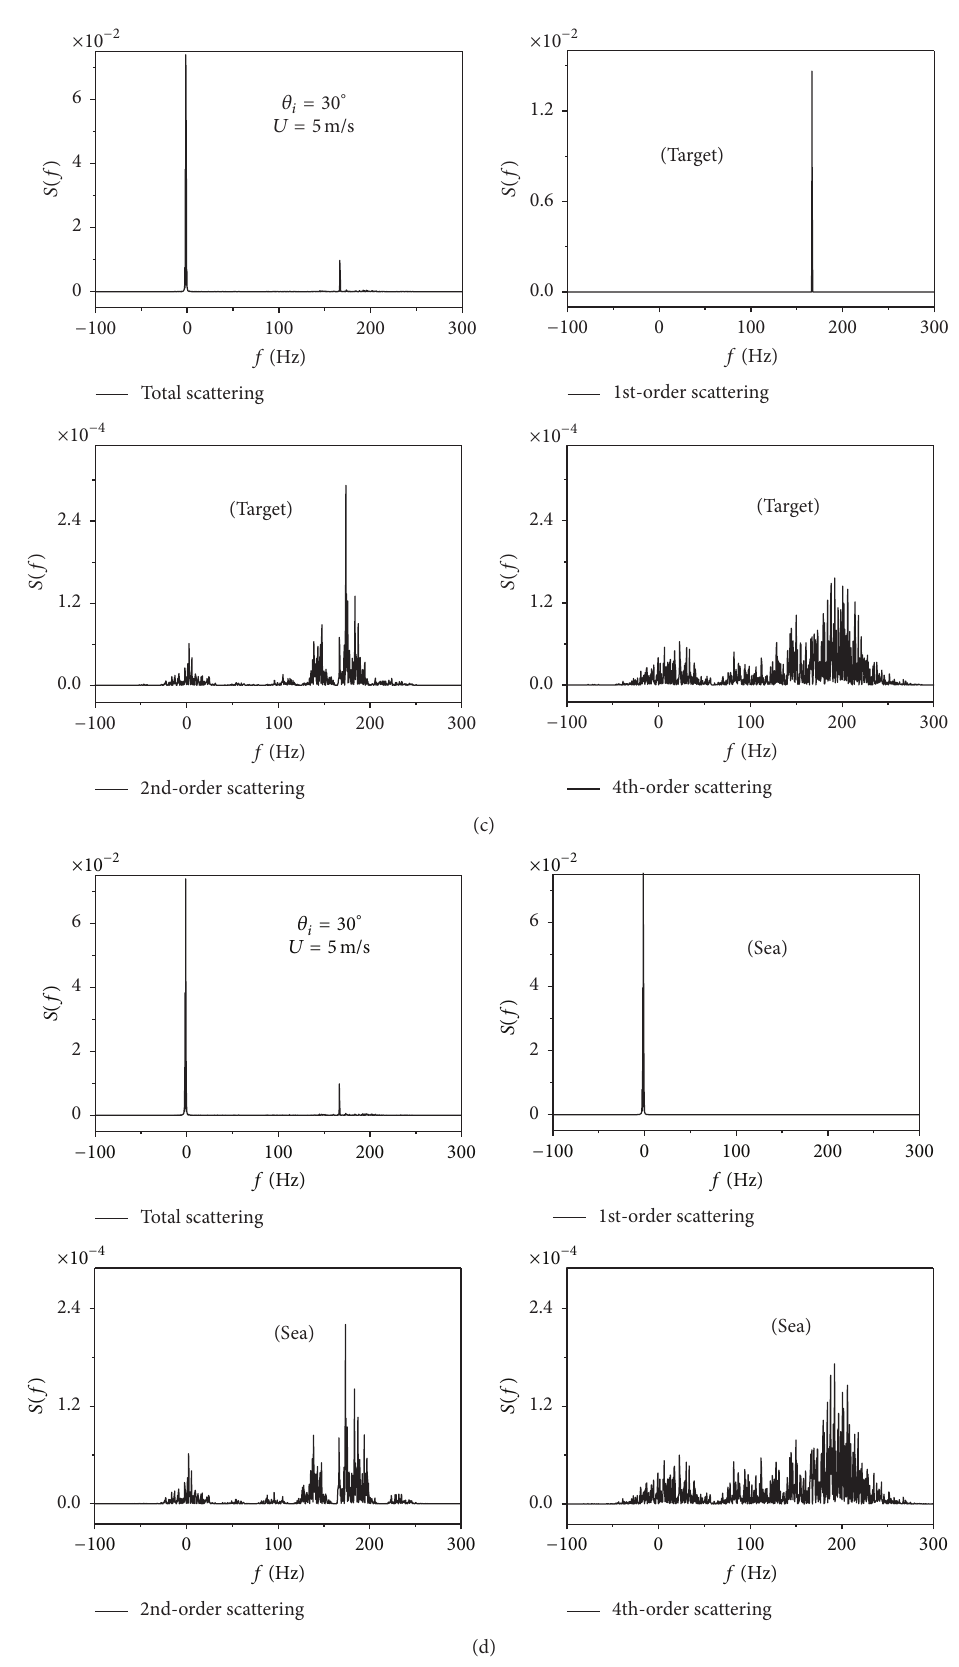
Figure 9: Doppler spectra of multiple scattering field. (a) Target ( 𝜃 𝑖 = 10 ∘ ). (b) Sea surface ( 𝜃 𝑖 = 10 ∘ ). (c) Target ( 𝜃 𝑖 = 30 ∘ ). (d) Sea surface ( 𝜃 𝑖 = 30 ∘